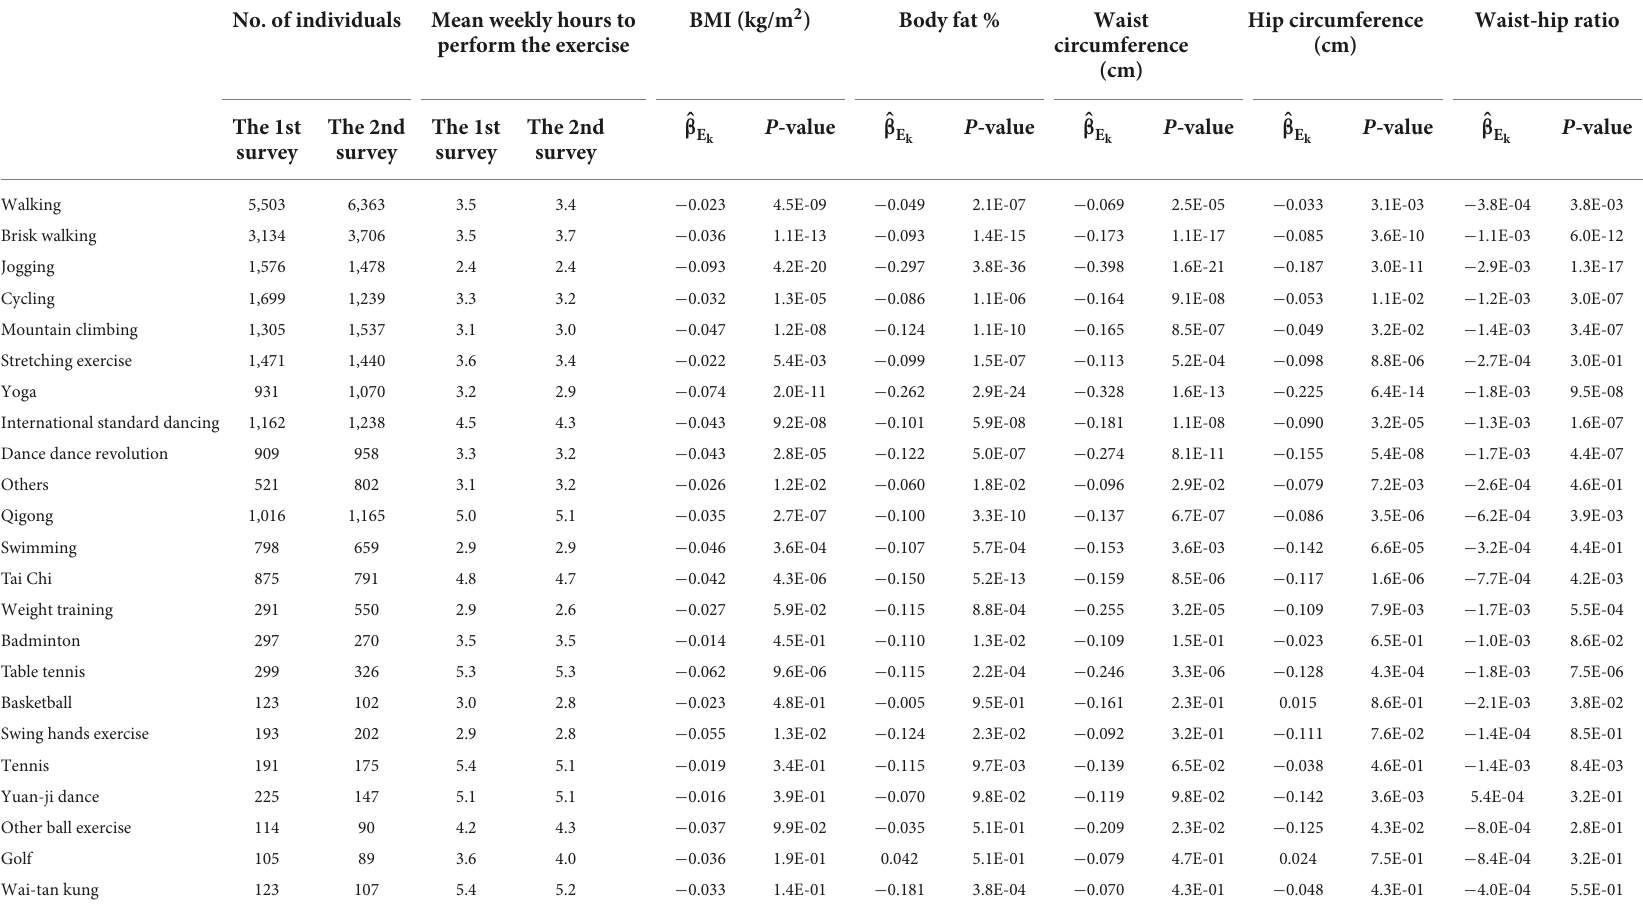
TABLE 2 Associations of weekly hours to perform 23 physical exercises with five obesity